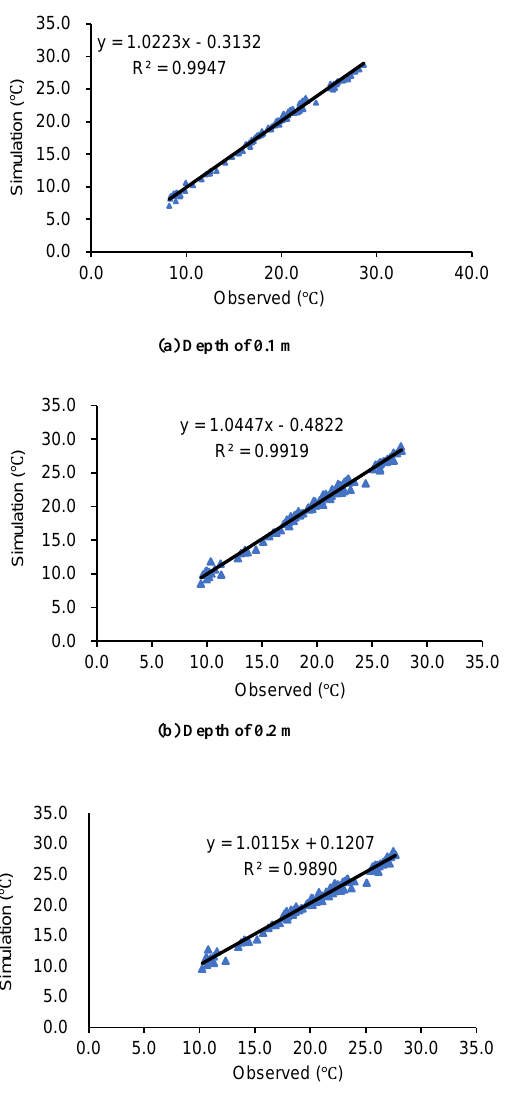
Figure 5. Linear regression and coefficient of determination of the observed and simulated average soil temperatures at different depths.